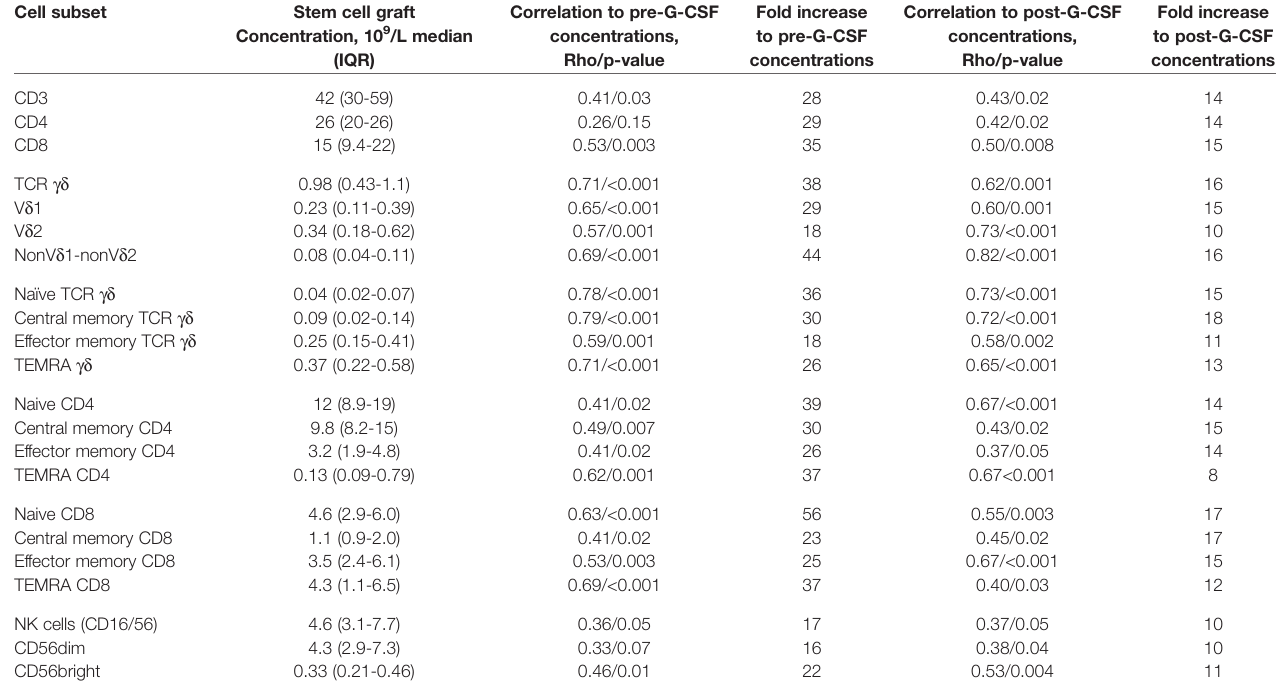
Rho correlation coef fi cient and p-values from Kendall ’ s tau-b test for correlation to peripheral blood concentration before and after G-CSF. Median fold